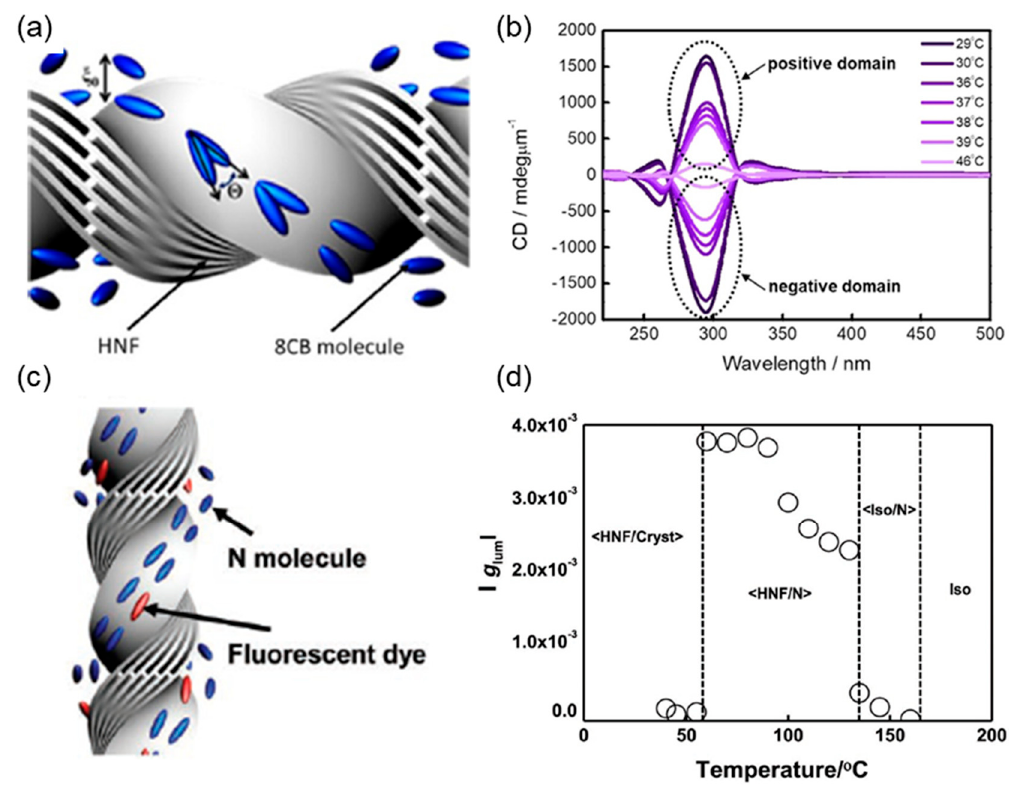
Figure 12. Templating applications of HNF to transfer its chirality to other achiral materials. ( a ) Schematic illustration of the helical assembly of achiral nematic LC phase on the HNF’s surface. ( b ) CD analysis of HNF / N mixture depending on the temperature. CD signal is amplified when 8CB is in its nematic phase. Reprinted with permission from [46], Copyright 2017, Wiley-VCH. ( c ) Sketch of chirality transfer from HNF to fluorescent dye molecules when they are co-aligned with N molecules. ( d ) g lum of the mixture of HNF / N / dye with temperature variation. Reprinted with permission from [47], Copyright 2019, Wiley-VCH.